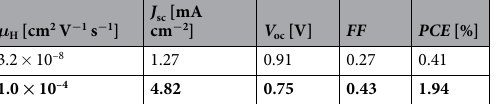
Table 1. Hole mobilities measured on films and photovoltaic characteristics of bi-layer cells PEDOT:PSS/D/ C 60 /Al under simulated AM 1.5 illumination at 80 mW cm − 2 before (plain numbers) and after TIC (bold